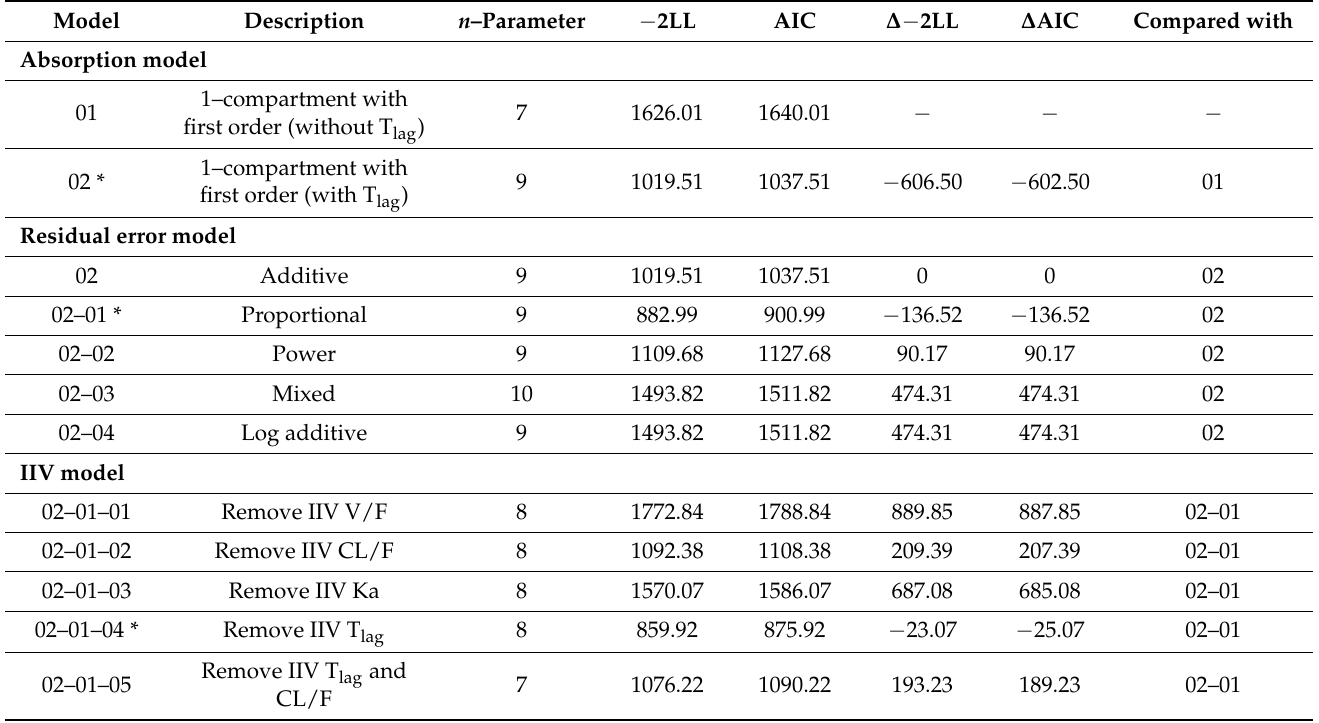
Table 3. Base structural model building